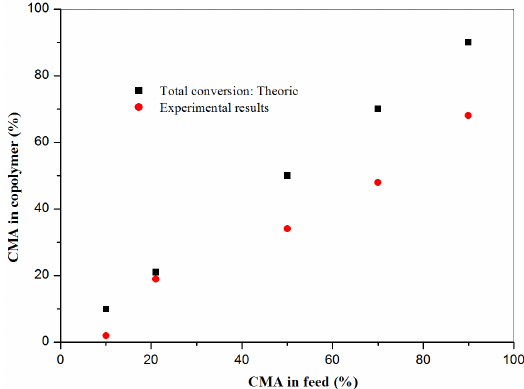
Figure 3. Composition curves for the copolymerization of CMA with